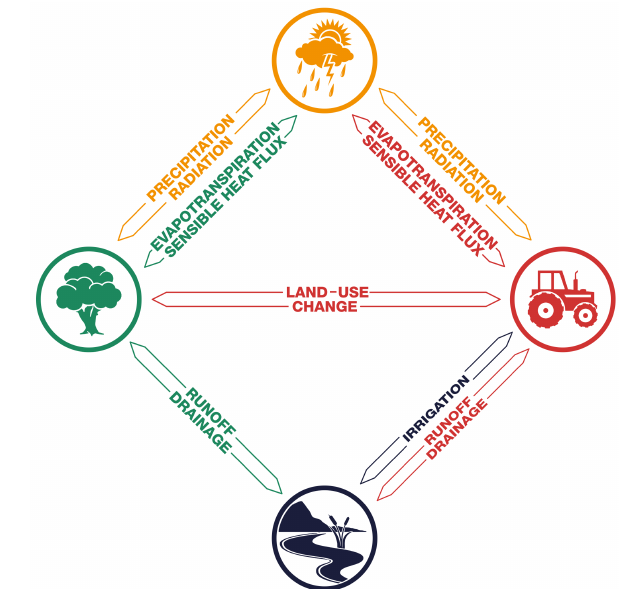
Figure 2. Agriculture–climate–interactions. The expansion of cul- tivated areas, i.e., land-use change, alters the characteristics of the terrestrial surface. It modifies the albedo, soil and vegetation charac- teristics that determine the exchange of energy, water and momen- tum between the land surface and the atmosphere. The consequent changes in the atmosphere’s energy and moisture content as well as shifts in wind patterns influence cloud formation and hence the dis- tribution of precipitation and radiation. The latter are key factors in the terrestrial hydrological cycle and determine evaporation, runoff formation and infiltration of water at the surface. Consequently they strongly affect the amount of water that is available for plants in the form of soil moisture and also the volume of water stored in terres- trial water bodies, the latter of which determines the irrigation water supply. The availability of energy, i.e., solar radiation, and water, i.e., precipitation and irrigation, in turn determines the productiv- ity of plants, defining the regions that sustain farming and where suitable lands can be converted into